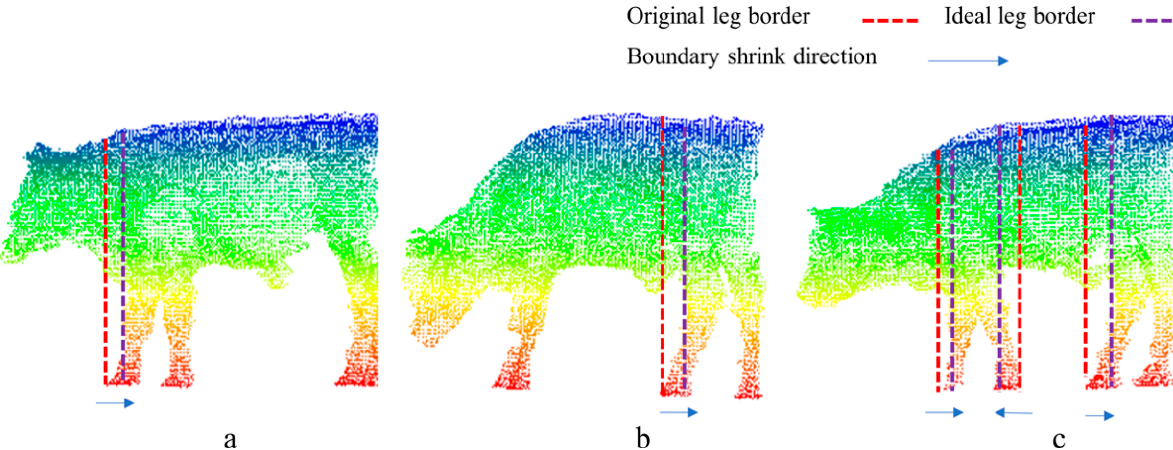
Figure 8. The errors arising from boundary calibration for beef cattle leg region. (( a ) Broadened foreleg region, ( b ) broadened hind leg region, ( c ) broadened regions of forelegs and hind legs). The area highlighted by the red dotted line represents the boundary of the leg region identified by the proposed algorithm. However, for the point clouds of beef cattle in a walking posture, the recognition result showed that the leg region was significantly enlarged (the foreleg region in Figure 8a, the hind leg region in Figure 8b, and both the foreleg and hind leg regions in Figure 8c), thereby lowering the accuracy. By contrast, the area highlighted by the blue dotted line reflects the actual situation for targeted